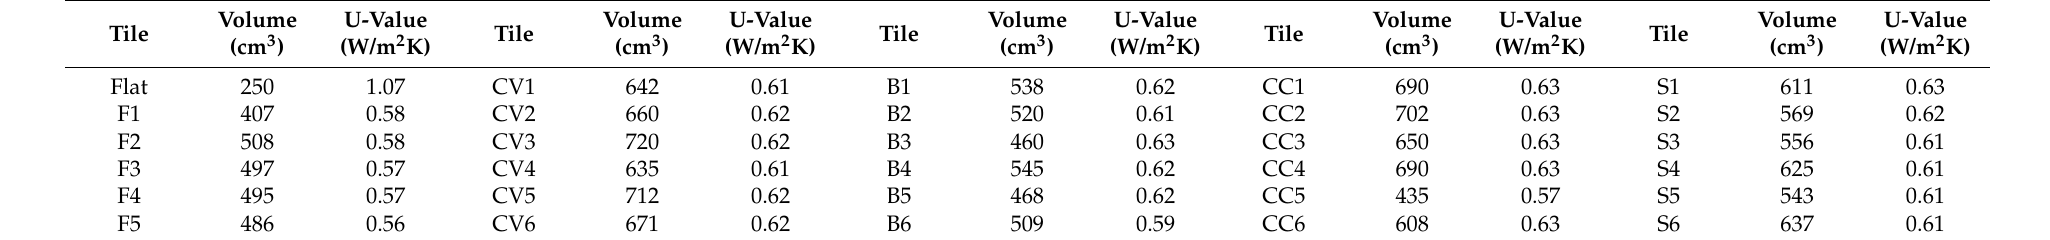
Table 1. Flat tiles (0.025 × 0.1 × 0.1 m 3 ) and sculptured tiles (0.075 × 0.1 × 0.1 m 3 ): material volume and overall heat transfer coefficients (U-values) (based on Hershcovich et al.